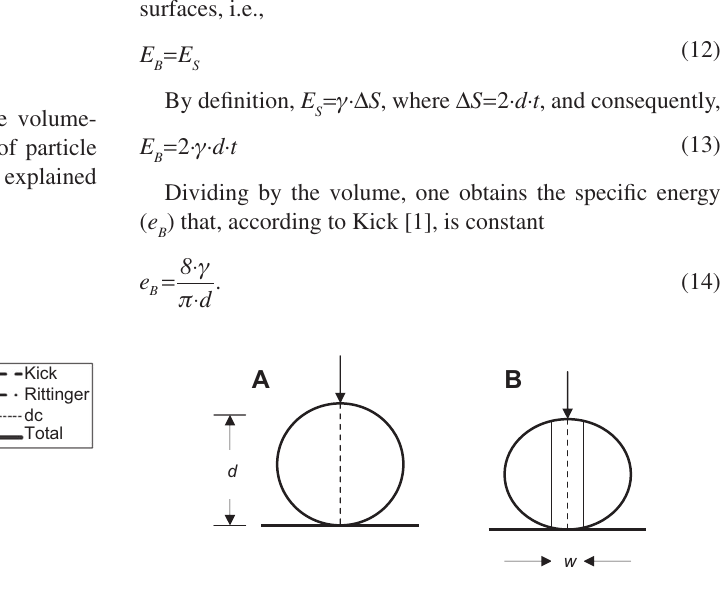
Figure 2 Theoretical specifi c energy-size relationship. Figure 3 Brazilian test confi